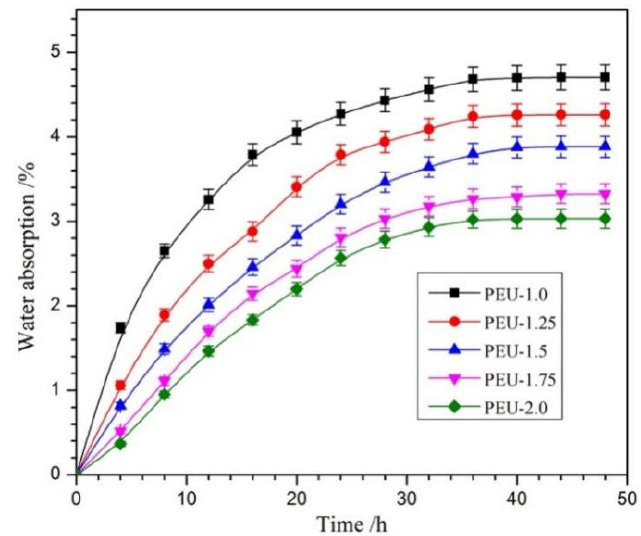
Figure 7. Water absorption of PEU films as function of immersion time ( n = 3).